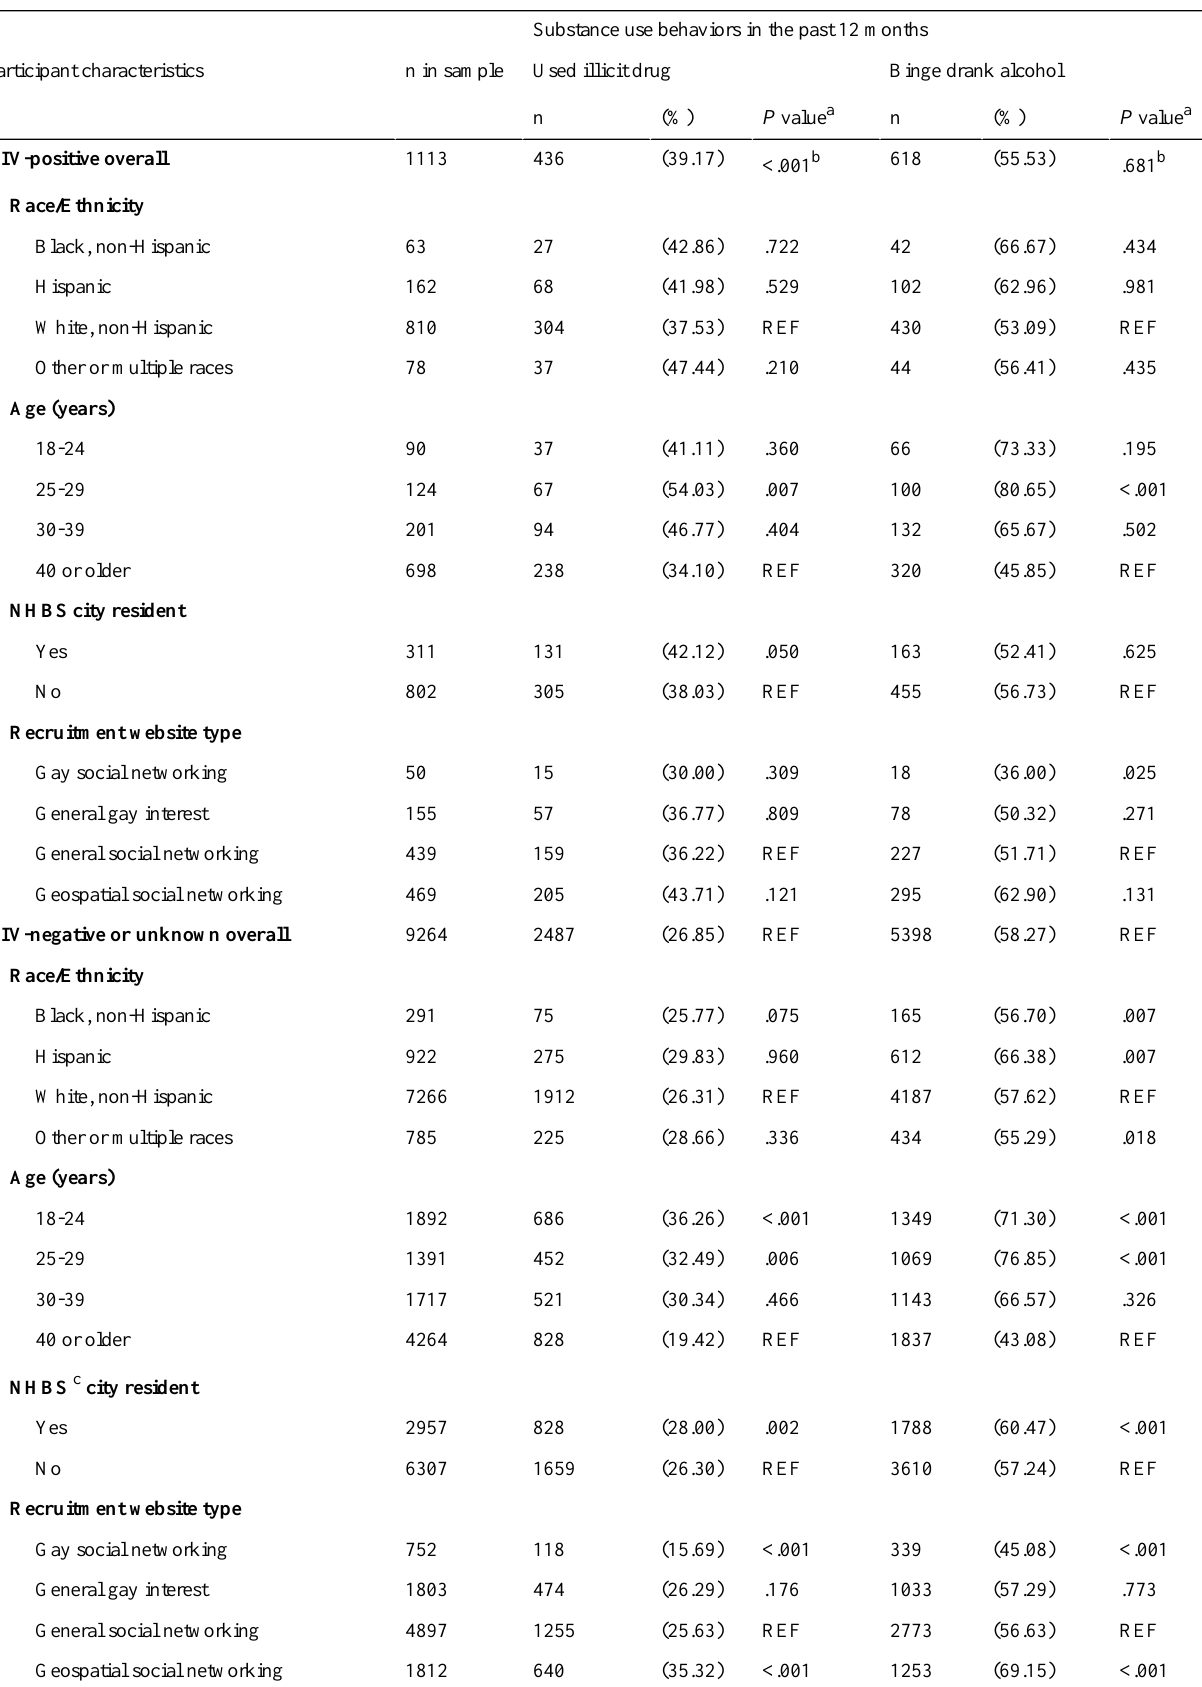
Table 4. Substance using behaviors of MSM participants in the American Men's Internet Survey, United States, 2013. Substance use behaviors in the past 12